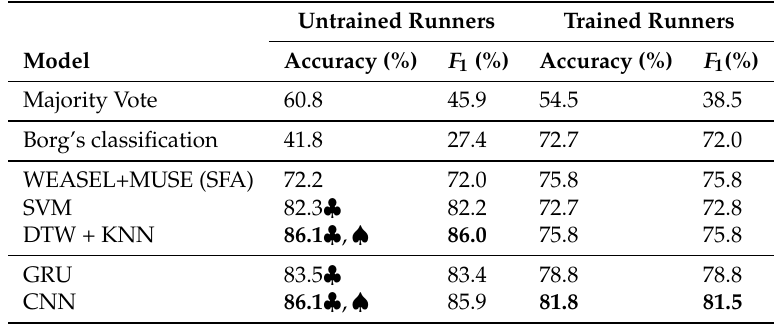
Table 4. Summary of the achieved classification results grouped by performance levels of the runners. The nomenclature remains the same as in Table 2. Labels were extracted from the overall evaluation procedure, and not each runner type trained separately. ♣ marks significant difference to the majority vote. ♠ marks significant difference to SFA. The best results are printed in